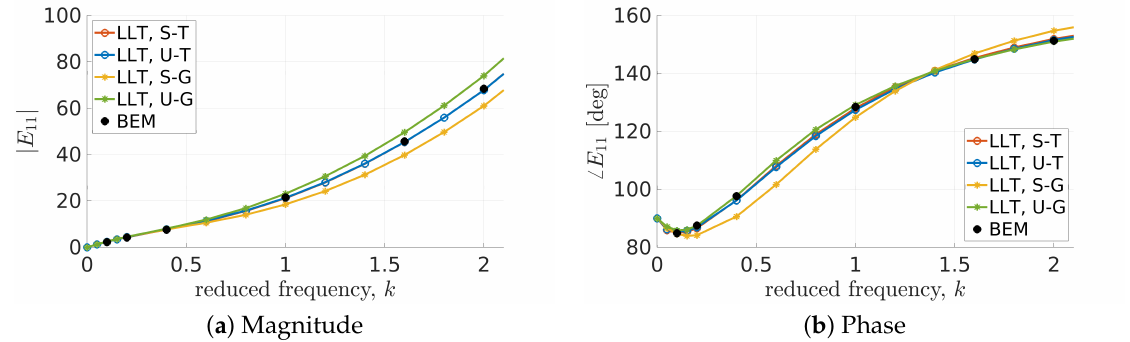
Figure 1. Transfer function E 11 ( k ) , constant shape functions, l = 5m.